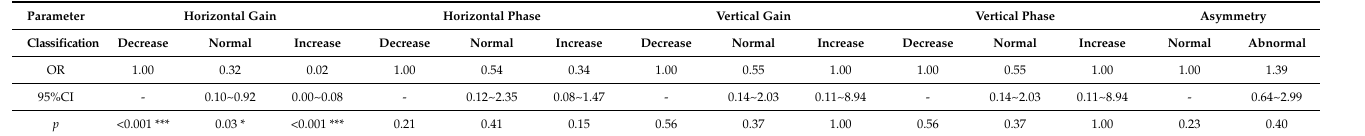
Table 2. Analysis of different VAT parameters to differentiate MD and VM patients by univariate binary logistic regression.